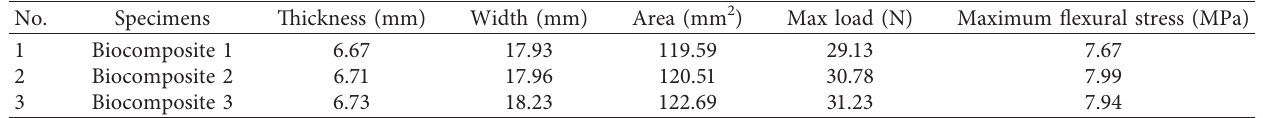
Table 5: Biocomposite press strength.